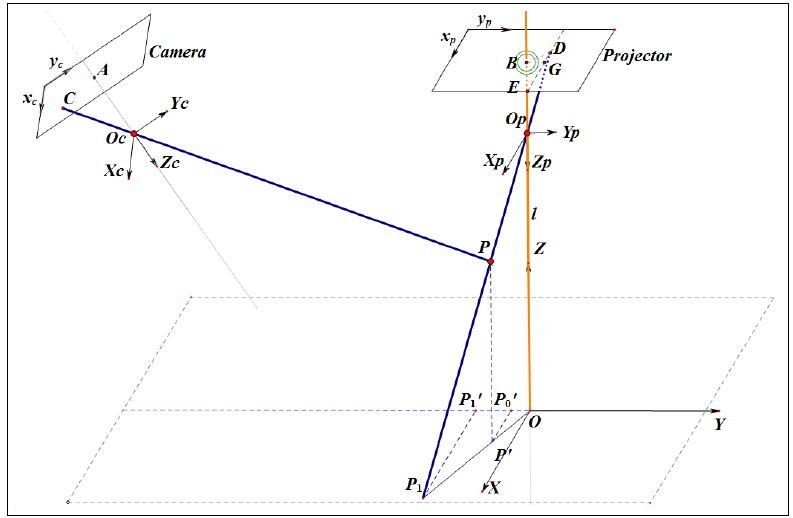
Figure 1. Geometrical model for the phase to depth